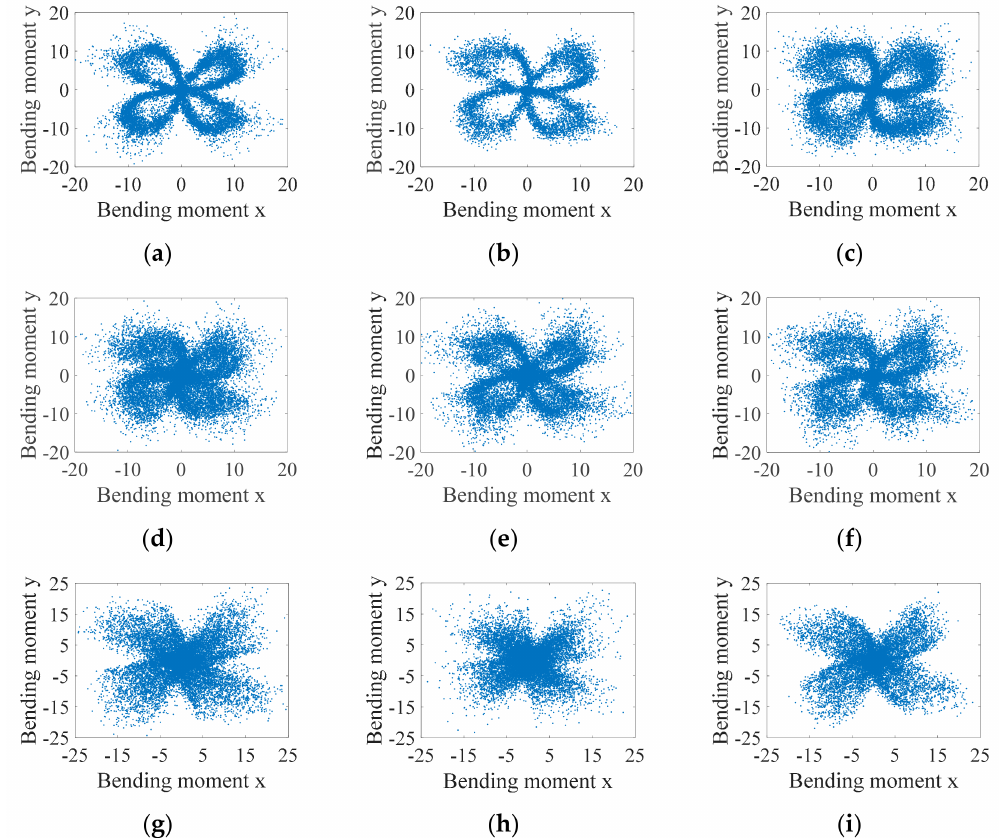
Figure 10. Polar plot of cutting bending moment for chatter milling condition. ( a ) No. 10 experiment; ( b ) No. 11 experiment; ( c ) No. 12 experiment; ( d ) No. 13 experiment; ( e ) No. 14 experiment; ( f ) No. 15 experiment; ( g ) No. 16 experiment; ( h ) No. 17 experiment; ( i ) No. 18